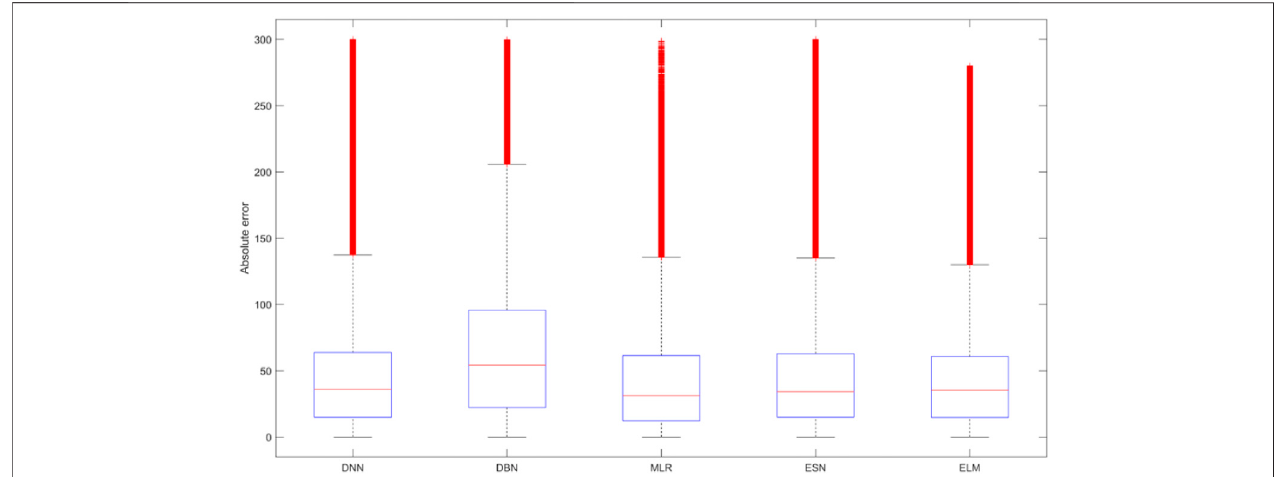
FIGURE 7 | Absolute error box plot of different